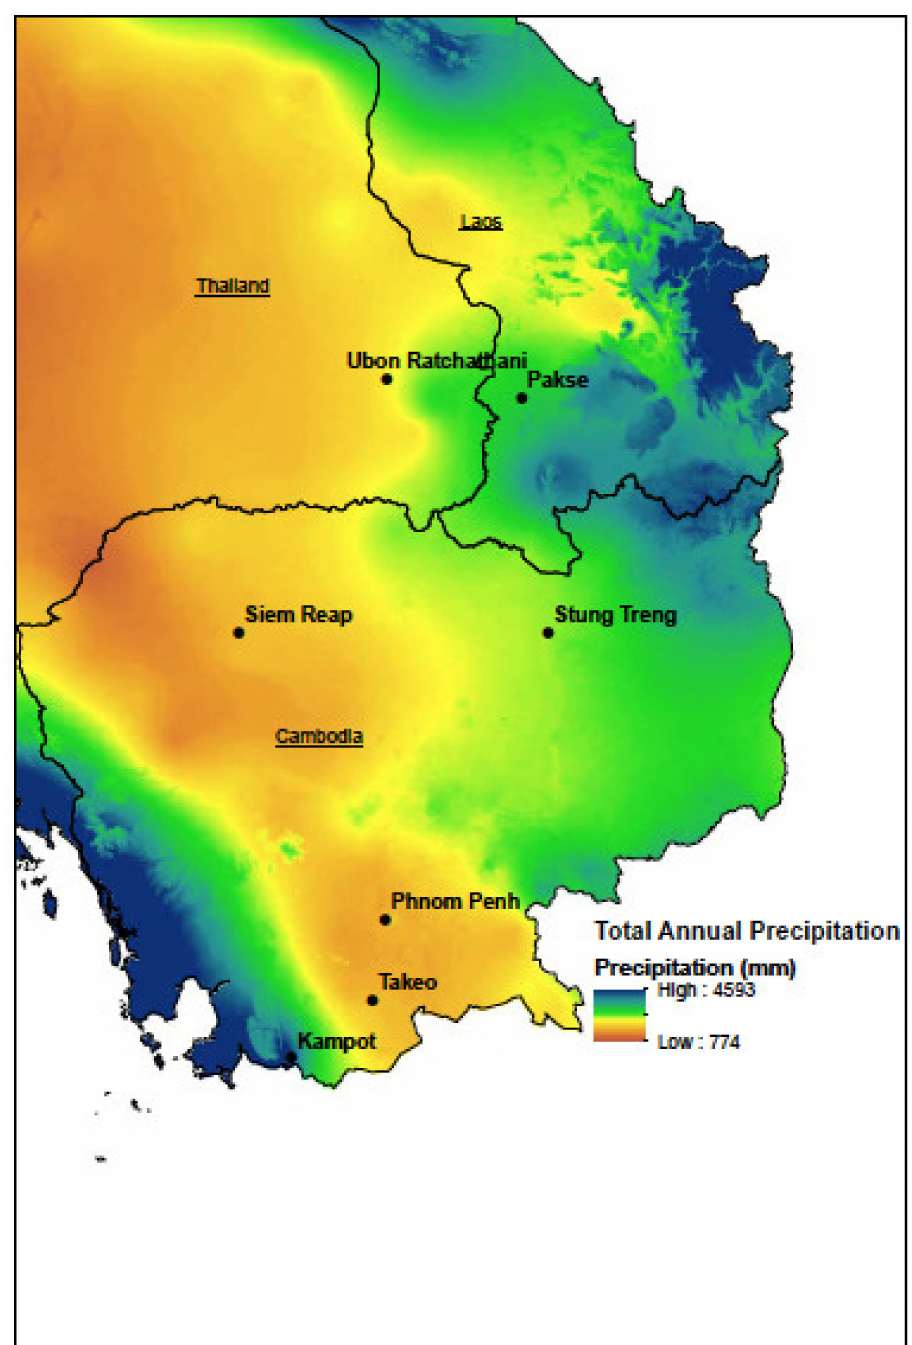
Figure 4. Location map for rainfall stations (see Figure 3). Total annual precipitation derived from the WorldClim bioclimatic variable: BIO12 [48]. Using a 1 km 2 spatial resolution with the temporal range of approximately 1970–2000